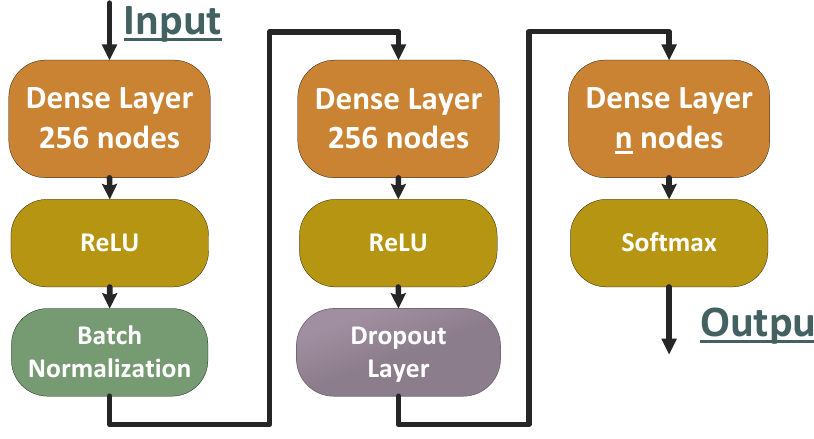
Figure 7. Network architecture of the generalizers